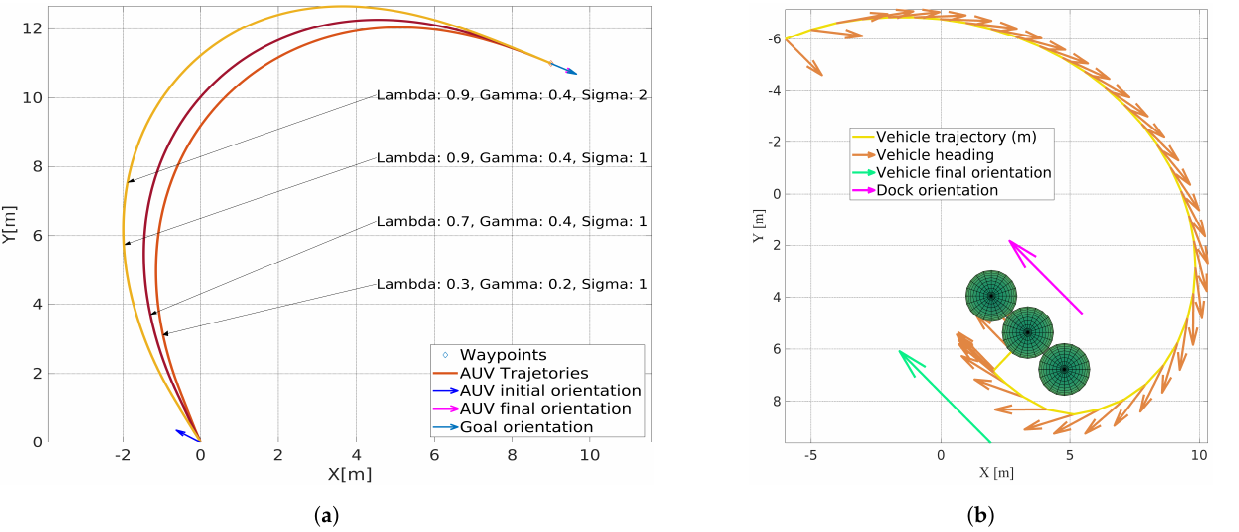
Figure 8. X300: ( a ) Comparison between different maneuvers in free space parking by changing the linear gain, angular gain, and modulation parameters. ( b ) Maneuver showing the vehicle performing a docking to a docking station travelling towards the